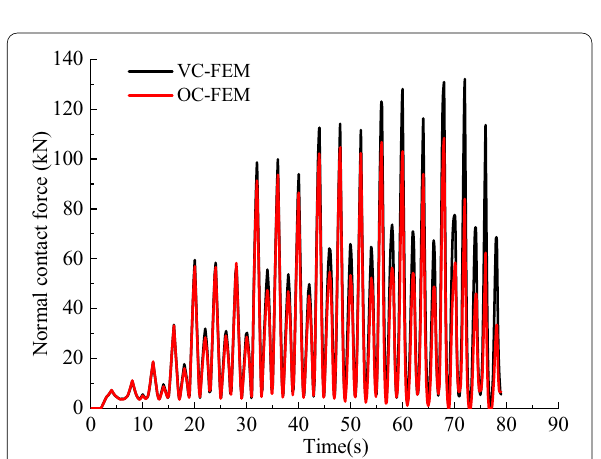
Fig. 35 Comparison of frictional energy dissipation between two simulation